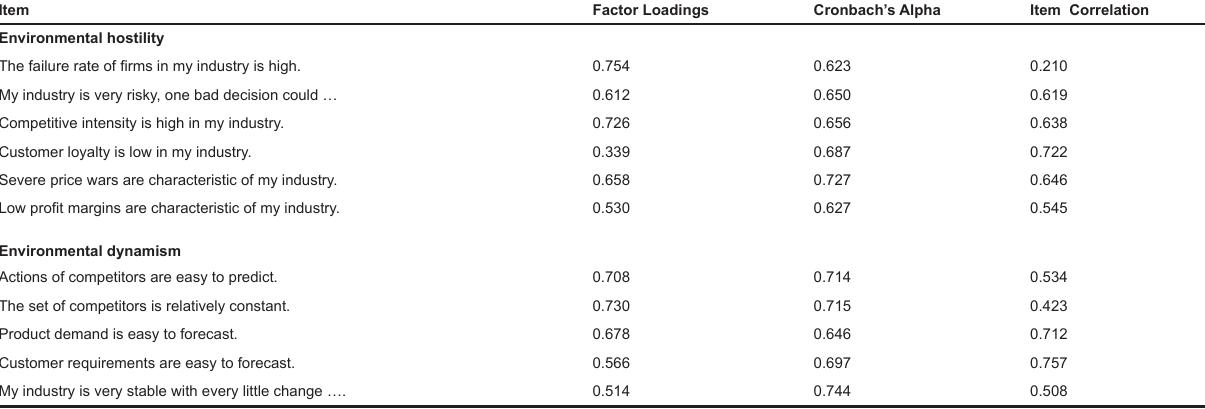
TABLE 6 Factor Matrix for environmental scales: Reliability and